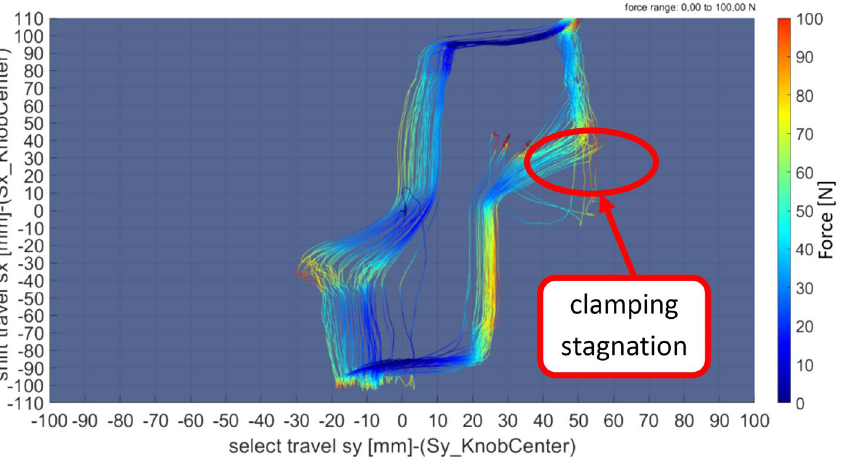
Figure 8. The actual diagram of cross shift